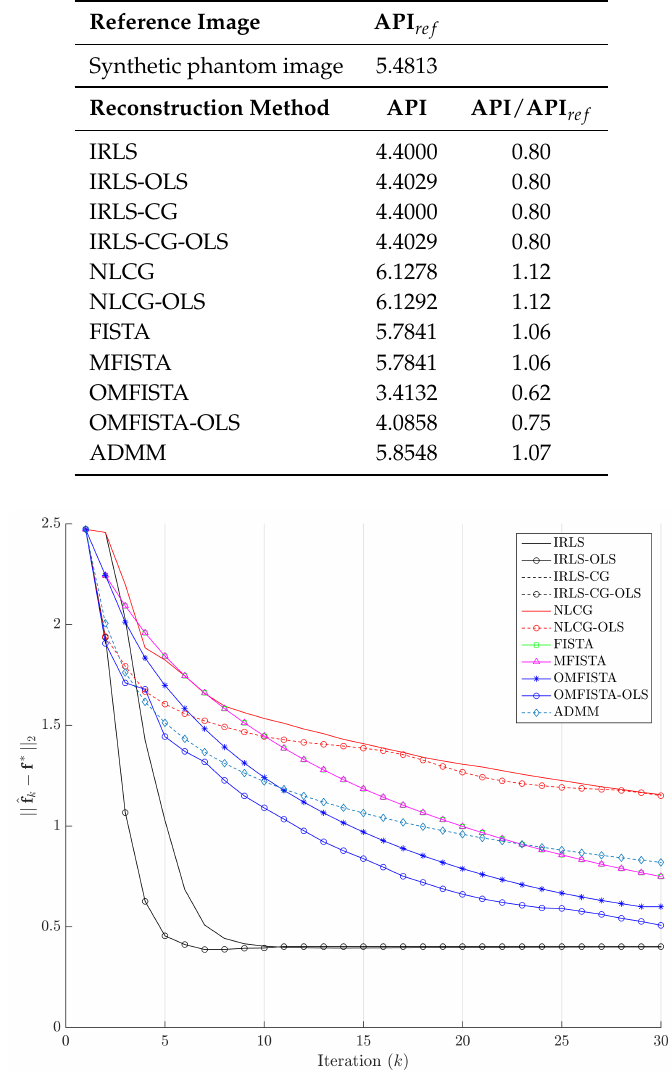
Figure 13. Estimation errors || ˆ f k − f ∗ || 2 along iterations - Synthetic